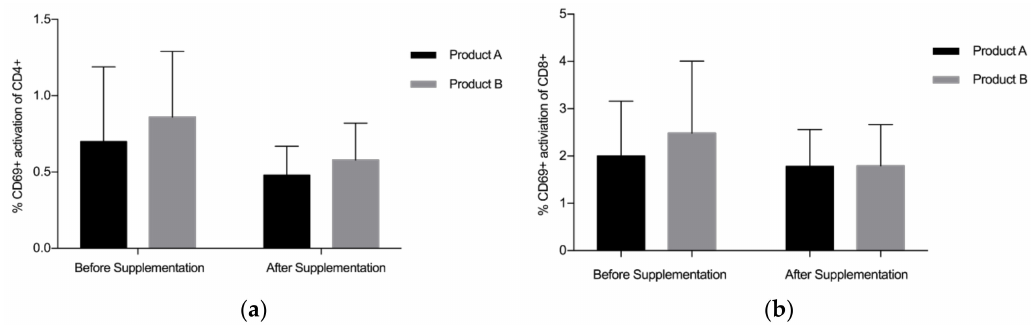
Figure 2. Pooled data from both dosages. ( a ) % CD69+ activation of CD4+ for Products A and B, ( b ) % CD69+ activation of CD8+ for Products A and B. Bars indicate standard deviation. * p < 0.05.